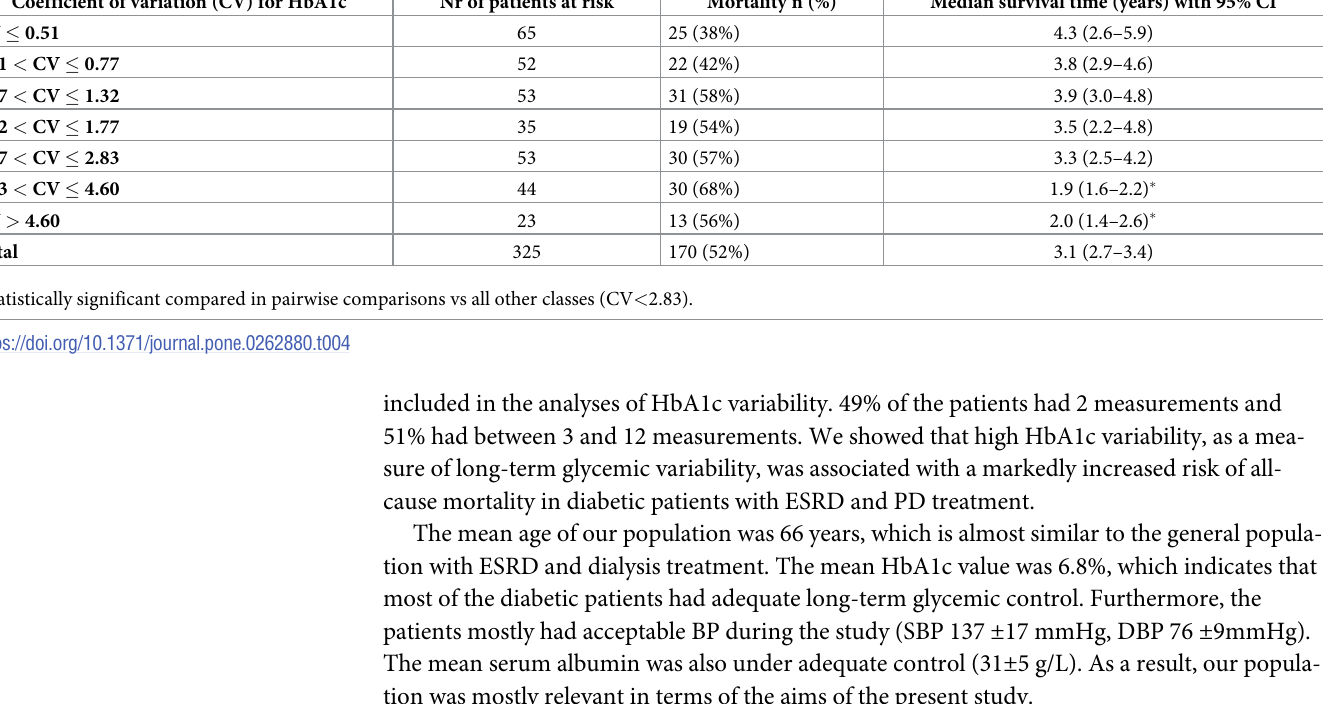
Table 4. Survival data according to HbA1c variability.